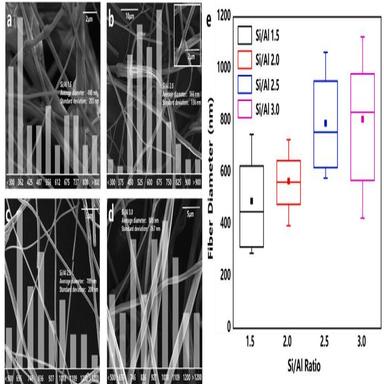
a–e Effect of different Si/Al ratios on the nano geopolymer's morphology: (a–d) Frequency distribution histogram of the fiber diameter with different Si/Al ratios; (e) Box chart analysis for the variety rule of the fiber diameter distribution and Si/Al ratios.